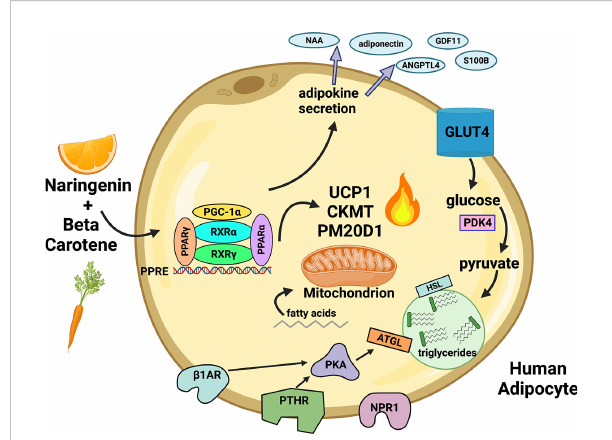
FIGURE 9 Proposed paradigm for remodeling of white adipocytes by